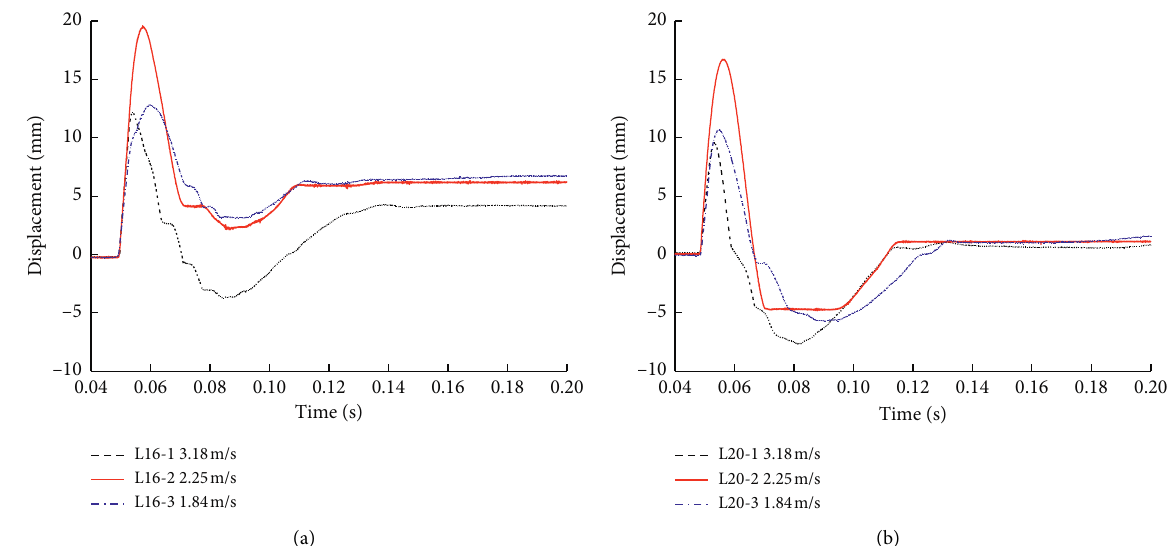
Figure 4: Time-history curves of the displacements: (a) Group A; (b) Group B.